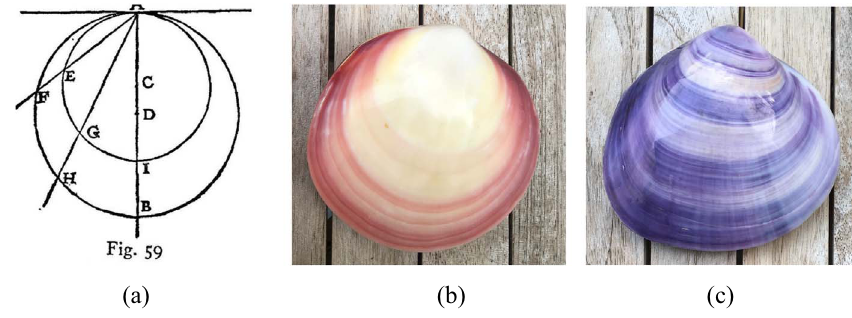
Figure 34. (a) Galilei ’ s original fi gure, (b and c) growth rings in